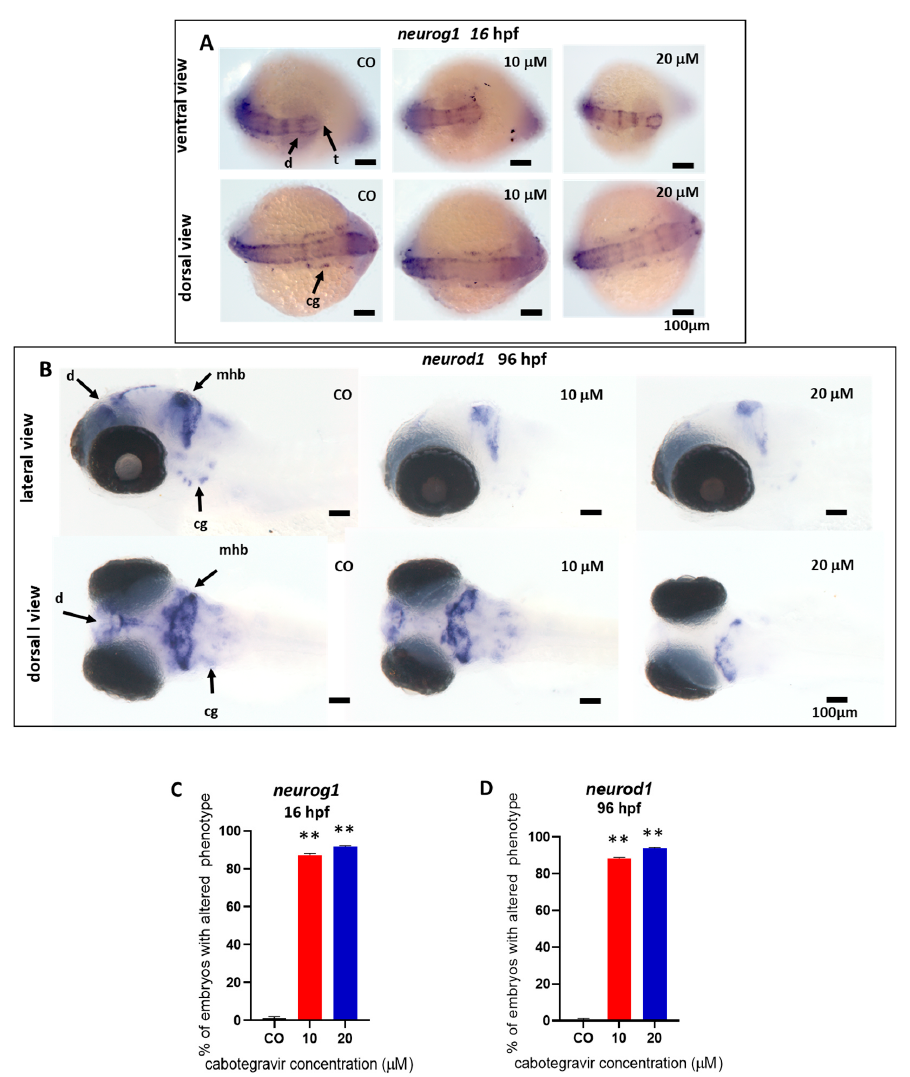
Figure 6. Analysis of the expression of neurog1 and neurod1 neural markers by whole-mount in situ hybridization (WISH) after treatment of zebrafish embryos with cabotegravir (CAB) by the immer- sion method. Representative images of WISH analyses of neurog1 and neurod1 expression in em- bryos treated with CAB by the immersion method. CAB was dissolved in fish water containing 0.1% dimethyl sulfoxide (DMSO). Fish water with 0.1% DMSO was used as negative control [CO]. ( A ) Ventral and dorsal views are shown for neurog1 expression at 16 h post fertilization (hpf); ( B ) lateral and dorsal views are shown for neurod1 expression at 96 hpf. ( C , D ) Percentages of embryos with defects. Experiments were performed twice with 25 embryos for each experimental point. (** p < 0.005 vs. control group). d, diencephalon; mhb, midbrain hindbrain boundary; cg, cranio facial gan- glia; t, telencephalon.